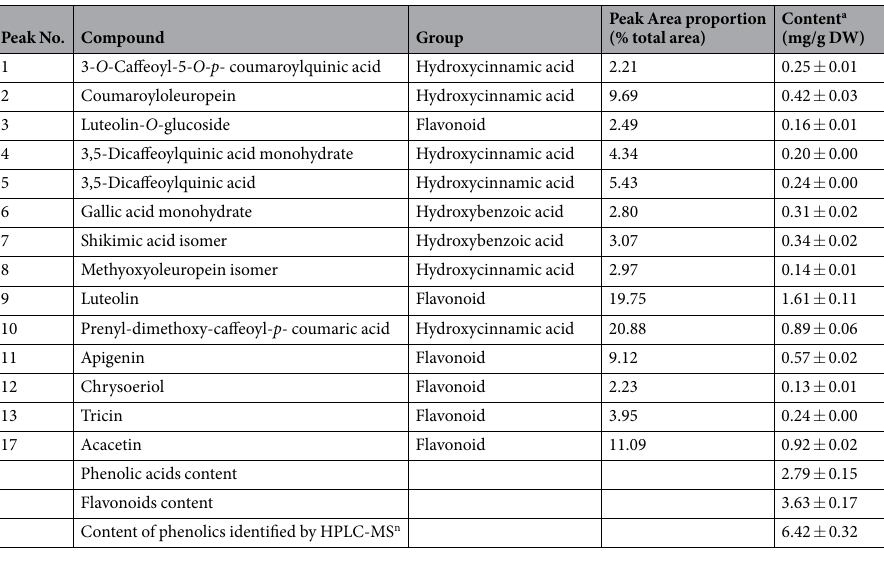
Table 5. Content of phenolic compounds in D . indicum var. aromaticum flower. a Mean ± SD (n =